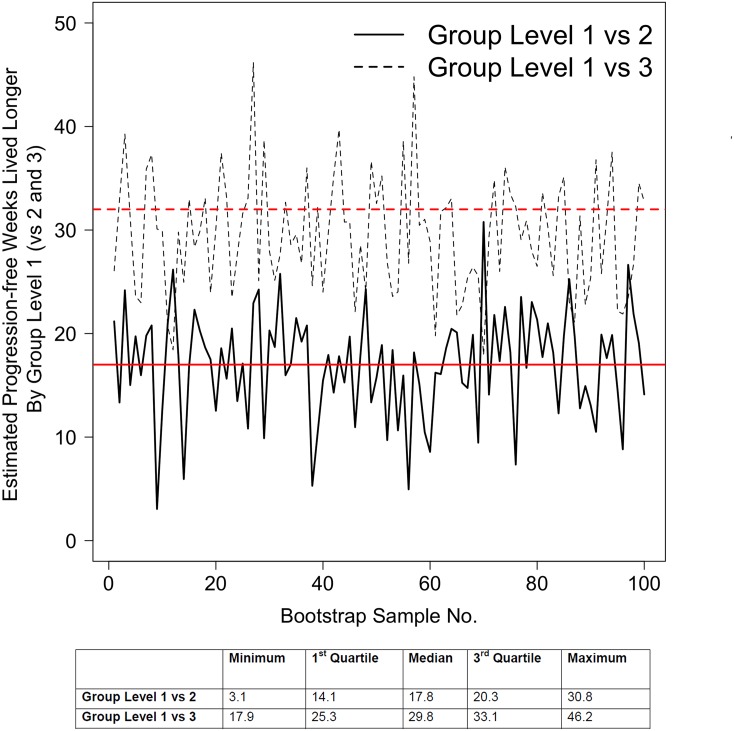
Sampling distribution of the number of progression-free weeks that group level 1 lived longer than group levels 2 and 3 over 80 follow-up weeks (Calculated via bootstrap methodology using 100 samples).Our cohort estimates are superimposed in red.